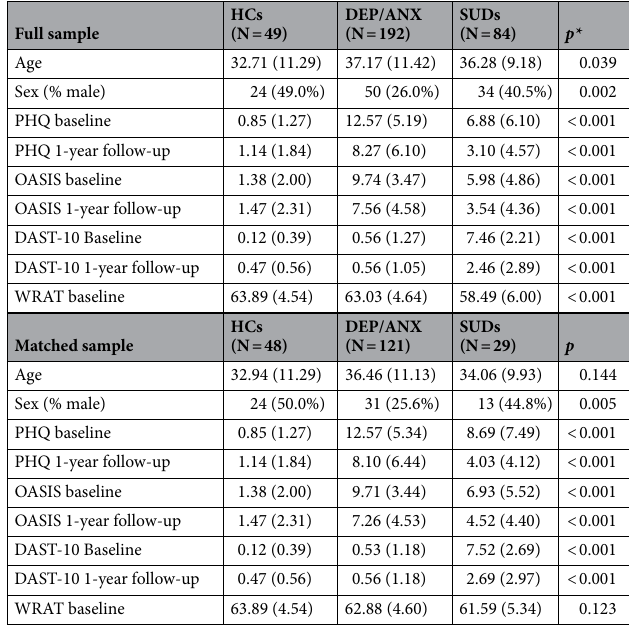
Table 1. Summary statistics (mean and SD) and group differences for demographic and clinical measures. *Based on ANOVAs testing for the presence of differences between